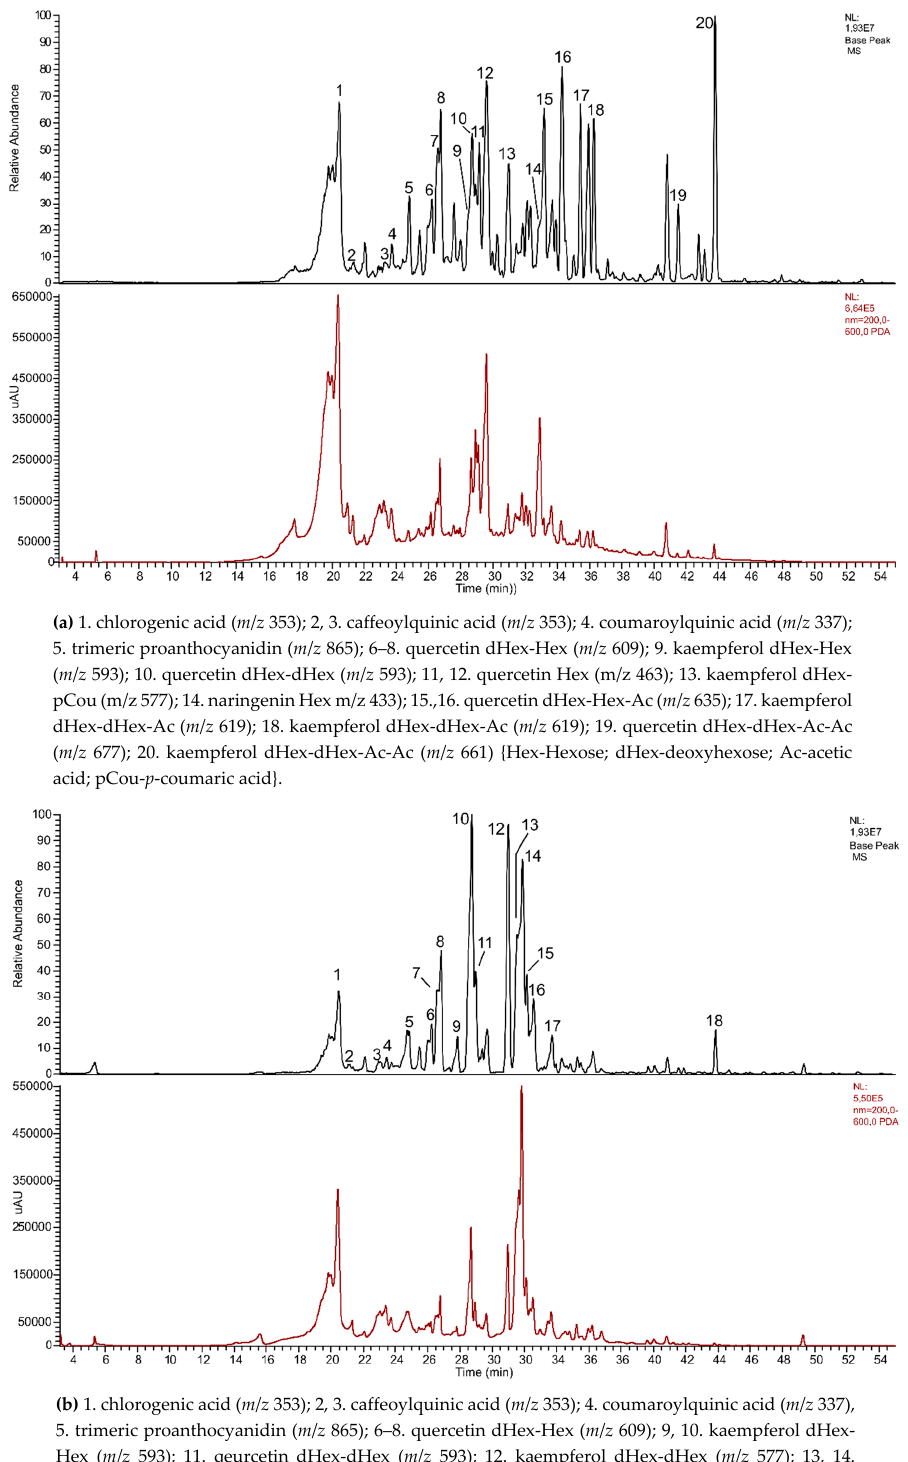
Figure 3. HPLC-MS and UV chromatograms (200–600 nm) of methanolic extracts from Chaenomeles japonica ( a ) leaves of field-grown plant and ( b ) micropropagated plantlets (shoot culture).